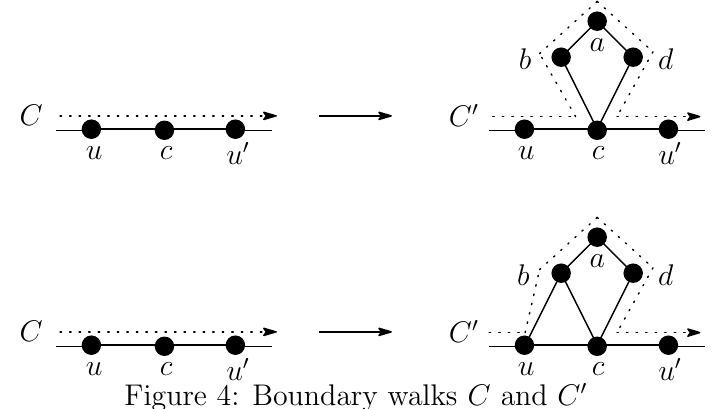
Figure 4: Boundary walks C and C